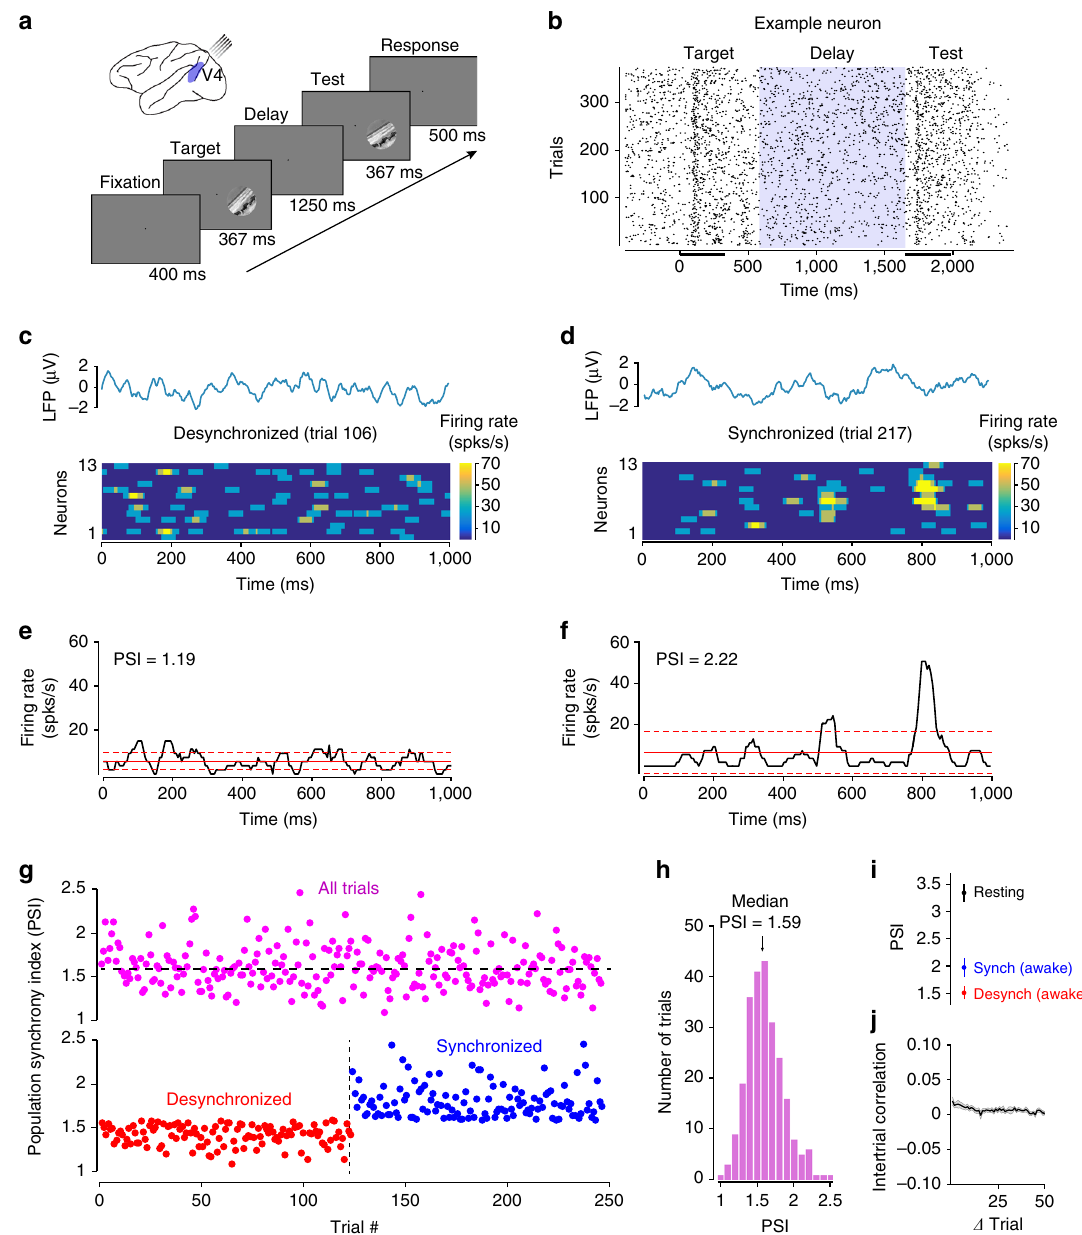
Fig. 1 Trial-by-trial fl uctuations in population synchrony in visual cortex. a Schematic representation of the recording site and experimental design. Animals were trained to report whether two brie fl y fl ashed successive natural scenes (target and test) were identical or different. b Raster plot of one example neuron. The blue shaded inter-stimulus delay period was used to measure population synchrony in each trial. The black bars under the x axis mark the time intervals when the two stimuli are presented. c , d Population response measured in individual trials from the same session — the neural population is desynchronized in trial 106 c and synchronized in trial 217 d . The blue traces represent local fi eld potential responses from the individual trials. e , f Population fi ring rate as a function of time for the example trials in c and d . The population of cells is desynchronized in trial 106 (PSI = 1.19, e ) and synchronized in trial 217 (PSI = 2.22, f ). The solid red line indicates the population mean fi ring rate; the red dotted lines indicate 1 s.d. from this mean. g top Trial-by-trial PSI for the example session from c – f . The horizontal line represents the median PSI value. Bottom: Trial-by-trial PSI after dividing the session into desynchronized (PSI below median) and synchronized trials (PSI above median). h PSI histogram for the example session in c – g . i Average PSI across sessions for desynchronized (red) and synchronized trials (blue). These PSI values are compared to the mean PSI when animals rest for a 20 – 30 min period (black). Error bars represent standard error. j The mean autocorrelation function (across sessions) of trial-by-trial